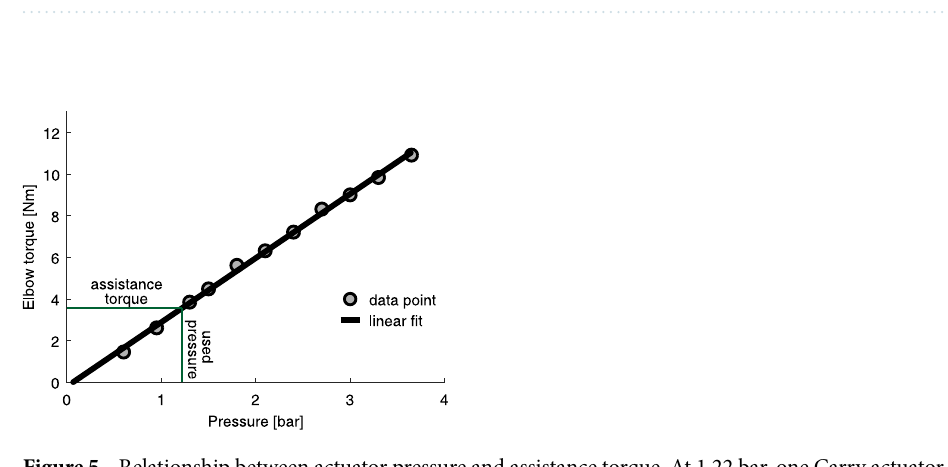
Figure 4. ( a ) Net metabolic rate and ( b ) relative change in the maximum elbow moment including standard deviation of the assisted (green) and unassisted (red) long holding and carrying scenarios (* p < 0.05 ).